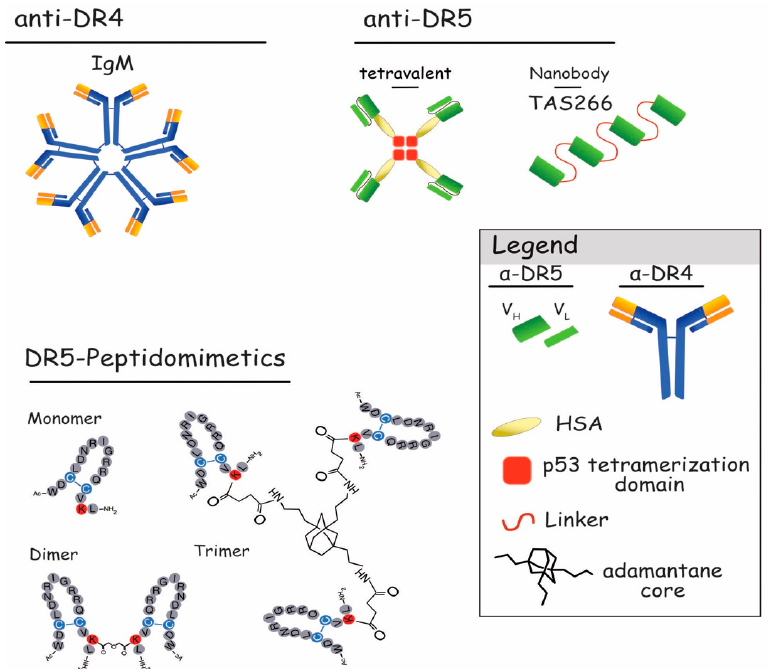
Figure 6. Schematic representation of DR4 or DR5 multivalent agonists. Represented on the upper left is the pentavalent IgM form of the newly described anti-DR4 antibodies [161]. The upper right shows tetravalent scFvs targeting DR5 [153] and TAS266 nanobody [154]. In the lower part, primary structures of DR5-peptidomimetics as monomer, dimer, and trimer are represented [152].